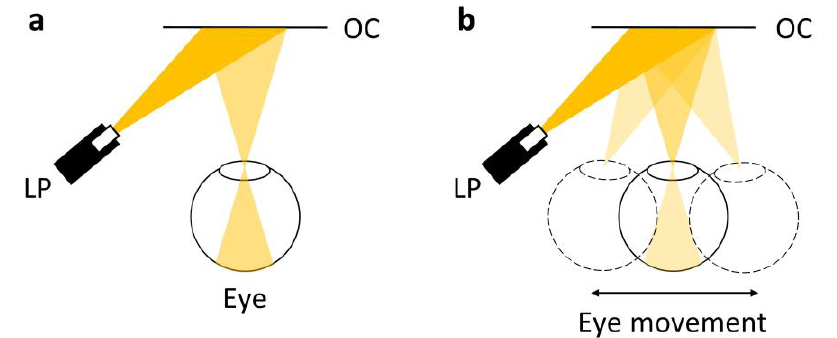
Figure 1. Schematic illustrations of ( a ) a typical Maxwellian view display and ( b ) a Maxwellian view display with enlarged eyebox. LP: laser projector; OC: optical combiner.